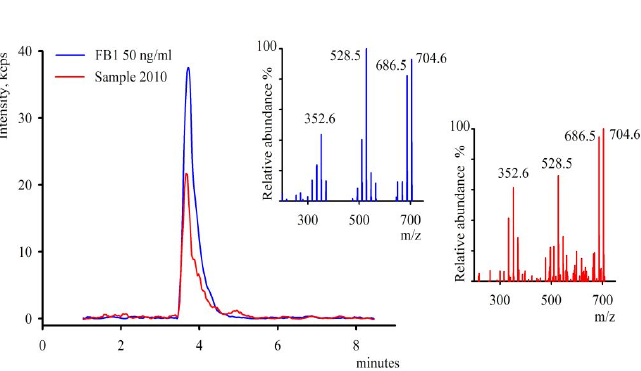
Fig. 4: Fumonisin B1 in naturally infected durum wheat kernels Identity of fumonisin B1 was confirmed by comparing authentic standard (blue) with sample extract (red) regarding retention time, m/z of the mother ion and fragmentation spectra